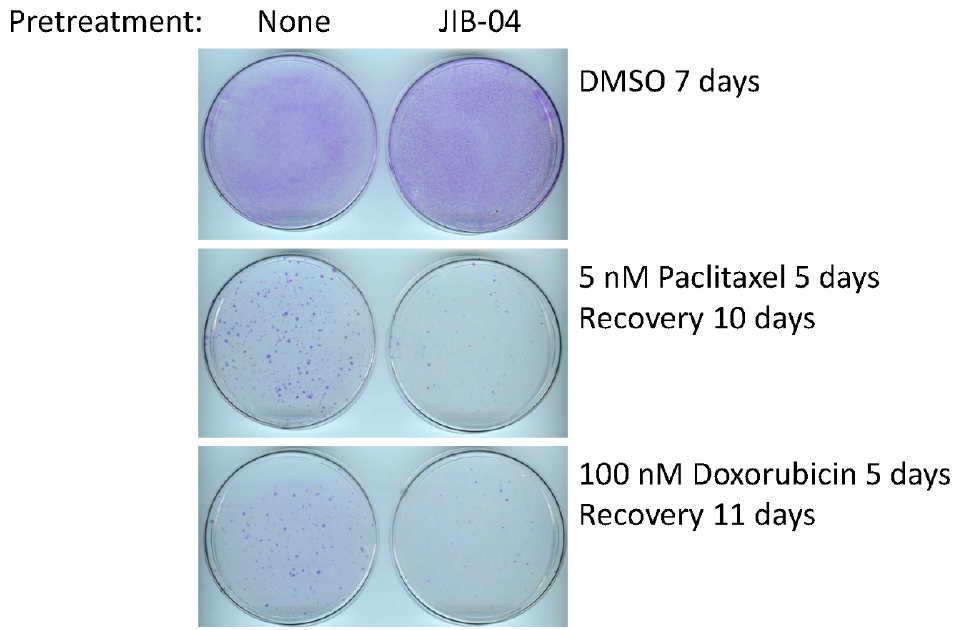
Figure 3. Pretreatment with JIB-04 sensitizes SUM149-Luc cells to chemotherapeutic drugs. After a 10-day treatment with 125 nM JIB-04, we allowed the surviving cells to recover in a drug-free medium for 15 days, trypsinized them, and plated them into fresh culture dishes. Following this, we treated the cells in parallel with 5 nM of paclitaxel ( middle panel) or 100 nM of doxorubicin ( bottom panel) for 5 days and then let them recover and grow into colonies for 10 or 11 days, as indicated before staining with crystal violet. Cells treated with DMSO in parallel and stained 7 days later served as controls ( top panel). These images show that pretreatment with JIB-04 significantly decreased the number of colonies.